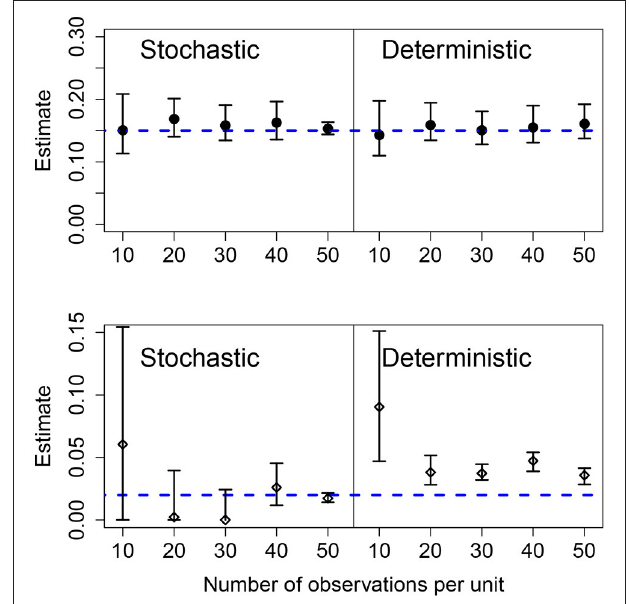
FIGURE 5 | Results of fits when there is a variable number of observations in each unit. The data in all cases was generated by a pure birth process with parametric variability. The top row shows the estimates for the mean growth rate with stochastic or deterministic fits, and the bottom row the estimate of the standard deviation of the growth rate. The horizontal dashed blue lines indicate the parameter values used in the data generation. The vertical whiskers are the 95% CI obtained in the fits. In each case, the number of units was U = 20, the growth rate was α = 0.15 and the standard deviation of the growth rate was σ =